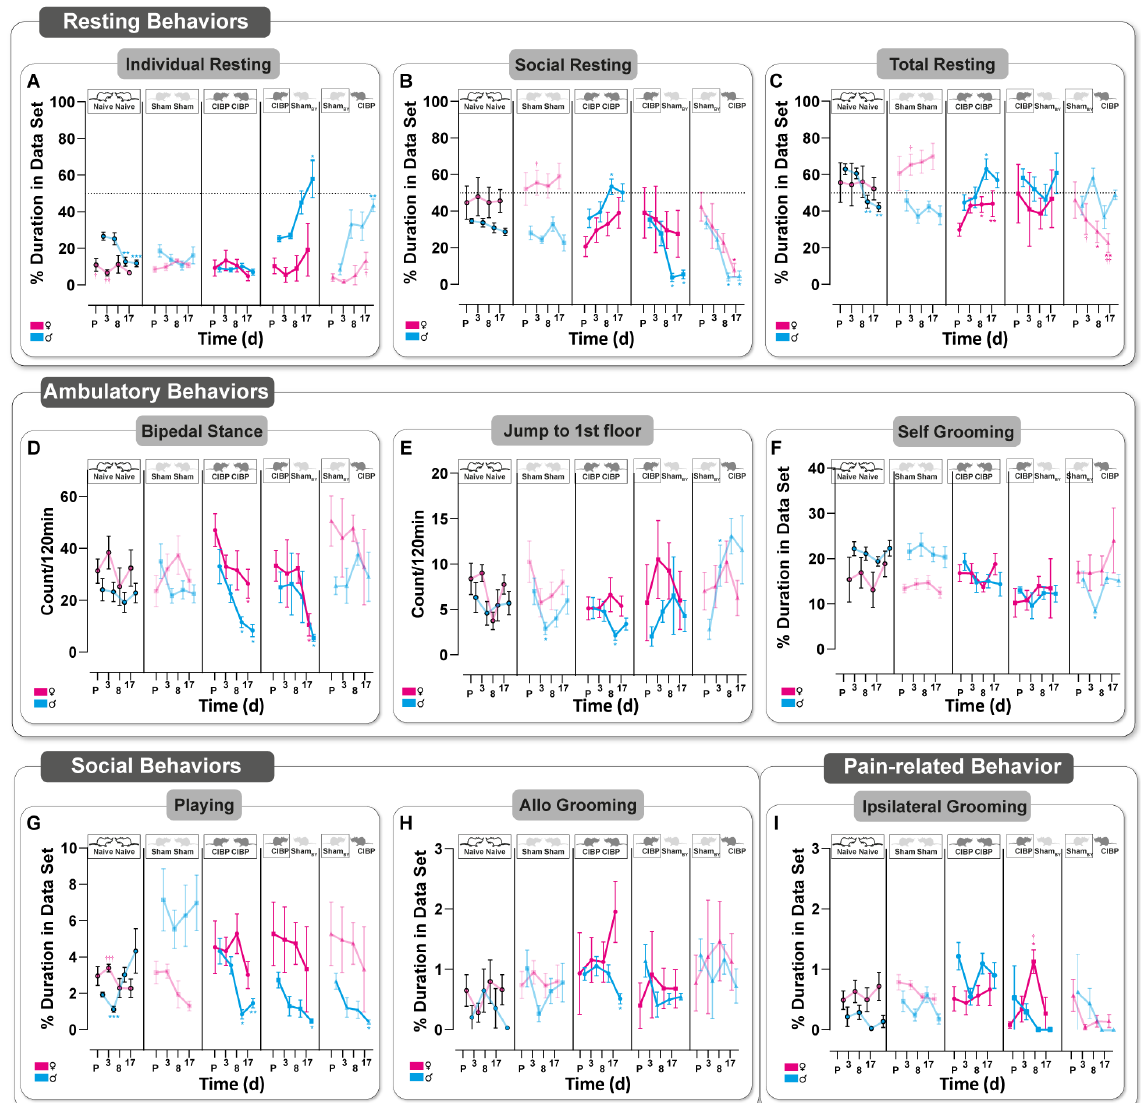
Figure 4. Bone cancer alters specific complex behavior in rats of both sexes. ( A – C ) Resting behavior was divided into individual ( A ), social ( B ), and total ( C ) resting. Significant differences to the pre-value are observed in the housing groups containing CIBP (CIBP-CIBP, shamBY-CIBP). ( D – F ) Am- bulatory behaviors were divided into a bipedal stance ( D ), jumping to 1st floor ( E ), and self-grooming ( F ). The bipedal stance was significantly reduced in tumor-bearing rats (CIBP). ( G , H ) Social behaviors were analyzed by assessing playing behavior ( G ) and allogrooming ( H ). Playing behavior was significantly decreased in male housing combinations, including CIBP rats. Allogrooming was significantly reduced in the CIBP-CIBP male housing combination. ( I ) Grooming of the tumor-bearing (ipsilateral) hindleg is a proxy for pain-related behavior. A significant increase in ipsilateral grooming was determined on 8 d in CIBP females housed together with shamBY. Four different housing combi- nations are shown here. Each housing combination was repeated 4 times with other animals ( n = 8, naïve; n = 8 sham; n = 8 CIBP; n = 4 CIBP-shamBY; n = 4 shamBY-CIBP). Boxes represent the data shown. Results are expressed as mean ± SEM. Two-way ANOVA (repeated measures based on GLM) followed by Dunnett’s multiple comparison test * for comparison to sham; p -Values: * ≤ 0.05, ** ≤ 0.01, *** ≤ 0.001. † for comparison to male; p -values: † ≤ 0.05, †† ≤ 0.01, ††† ≤